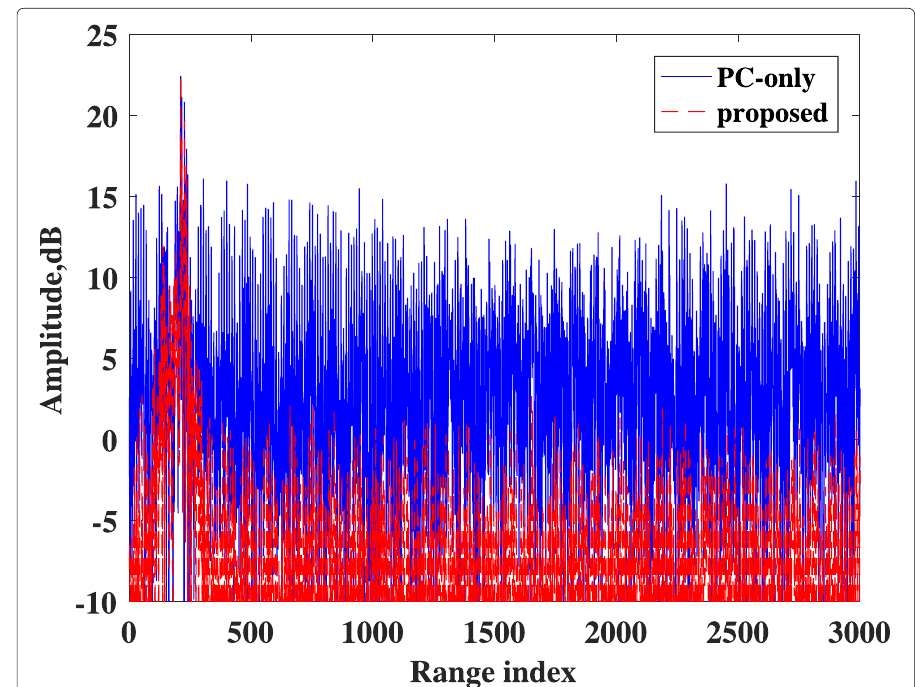
Fig. 12 Doppler channel slice corresponding to the target